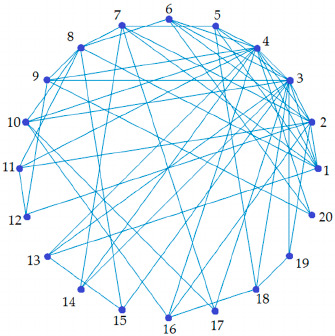
Figure 1. Twenty-node network used in the Figure 1. Twenty ‐ node network used in the experiments.